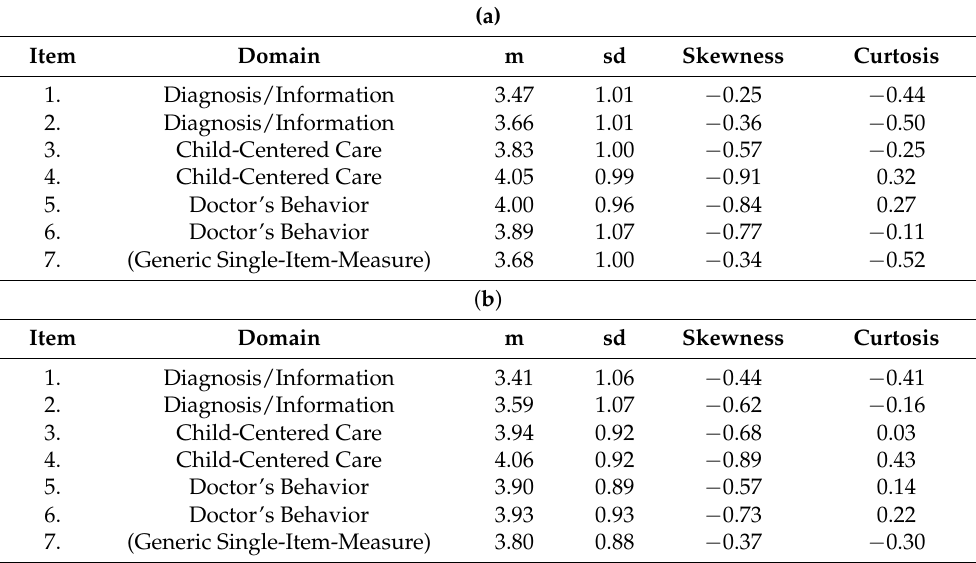
Table 1. ( a ) Descriptive item characteristics for the self-report of the CHC-/YHC-SUN-SF ( n = 469). ( b ) Descriptive item characteristics for the parents report of the CHC-/YHC-SUN-SF ( n = 370).